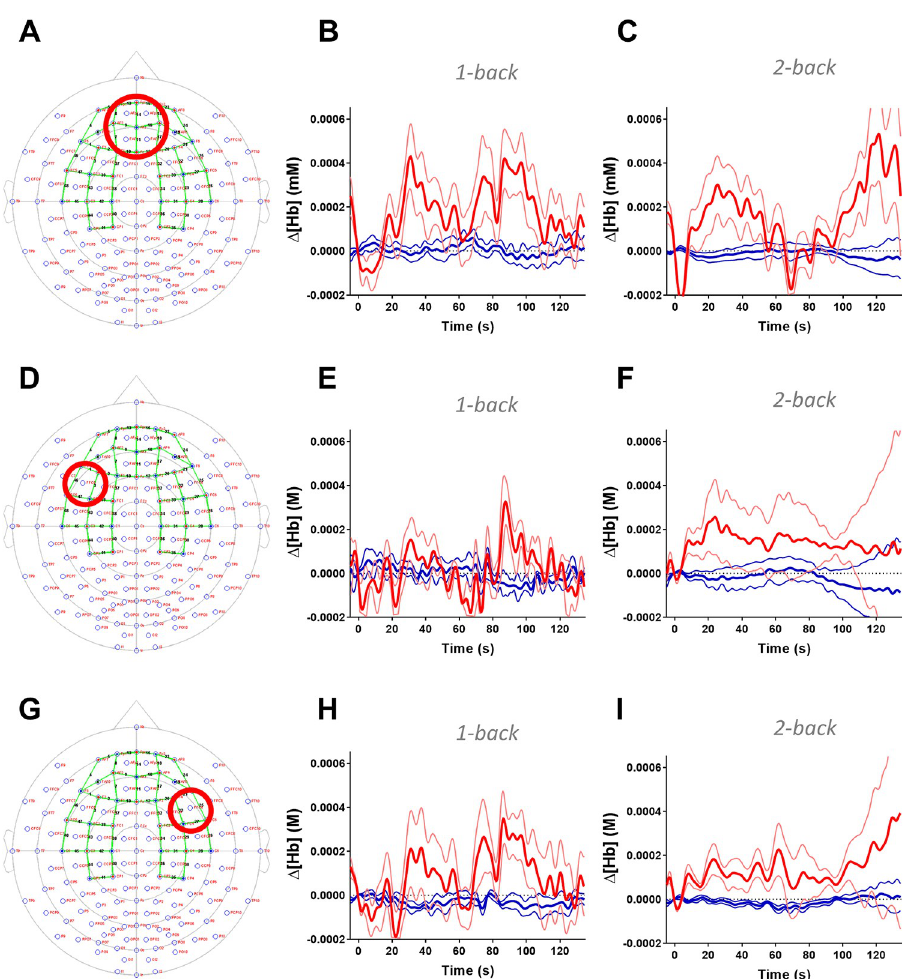
Fig 4. Block average traces over the prefrontal cortex and dorsolateral prefrontal cortex during the cognitive n - back stimulation using functional near-infrared spectroscopy. Group average traces of oxy-hemoglobin (HbO, red lines) deoxy-hemoglobin (HbR, blue lines) concentrations were plotted from medial prefrontal cortex (PFC; Panel A), left and right dorsolateral prefrontal cortex (DLPFC; Panel D and G). Region of interests are shown on Panel A, D, and G within the international 10–20 space, and green lines represent channels. 2-back cognitive tasks elicited visible changes in HbO and HbR levels with profound hemodynamic responses during 2-back condition in the medial PFC and left DLPFC (Panel C and F). DLPFC ROI based on Vassena et al. [10]. Mean ± SD is plotted for each channel. Data for individual channels are shown in S2 and S3